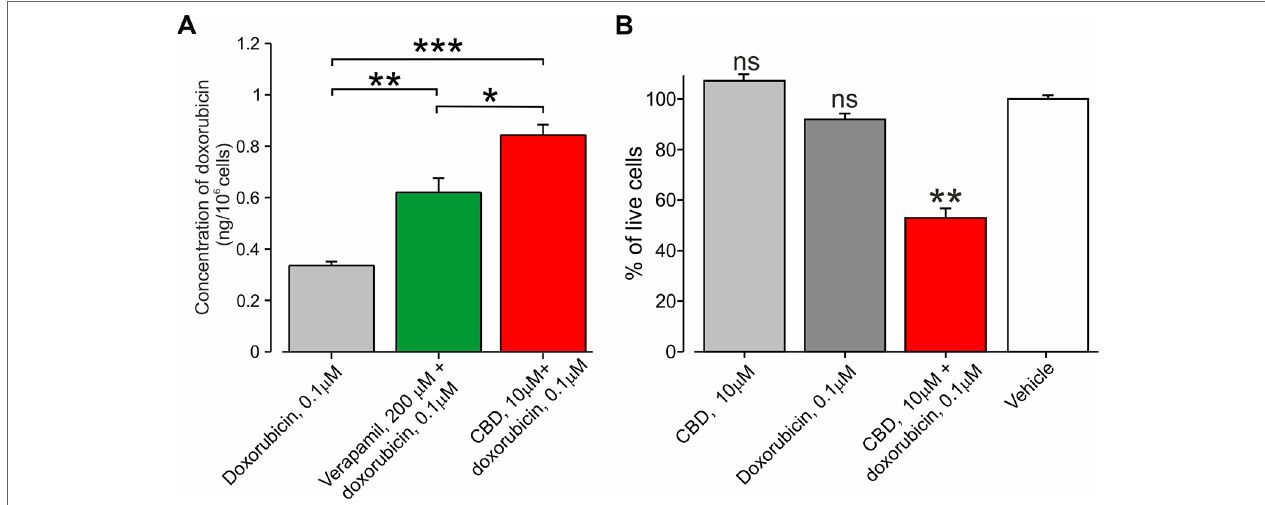
FIGURE 6 | Co-application of doxorubicin with CBD led to an increased amount of intracellular doxorubicin and increased cell death. (A) The concentration of doxorubicin in BNL1 ME cells (in ng/10 6 cells; see Methods ) following a 24-h treatment with 0.1 μM doxorubicin alone, 0.1 μM doxorubicin together with 200 µM verapamil, or 0.1 μM doxorubicin together with 10 μM CBD, measured using fluorometric analysis; n = 3 repetitions for each time point for each treatment group. (B) Live-cell fluorescence measurements from cultured BNL1 ME cells treated for 24 h with 10 μM CBD alone, 0.1 μM doxorubicin alone or co-application of 10 μM. CBD, and 0.1 μM doxorubicin. Note that only the co-application of CBD with doxorubicin produced a significant decrease in the number of living cells. *p < 0.05, **p < 0.01, ***p < 0.001, ns, not significant; one-way ANOVA, comparison between the vehicle to all other groups, n = 6 wells for each group, three